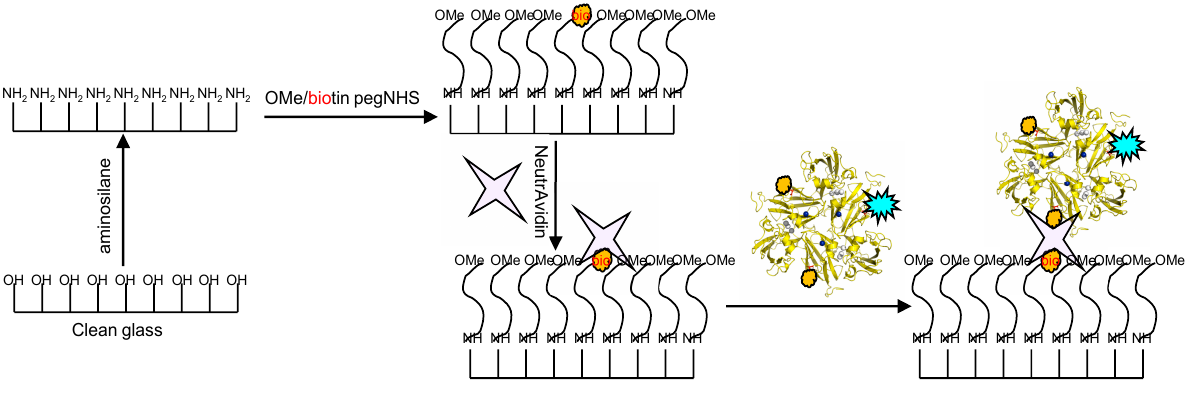
Figure 9. Scheme depicting the functionalization of glass coverslips with aminosilane and PEG linkers and immobilization of SLAC conjugates using the NeutrAvidin-biotin interaction. Reprinted with permission from [43]. Copyright 2014 The American Chemical Society.